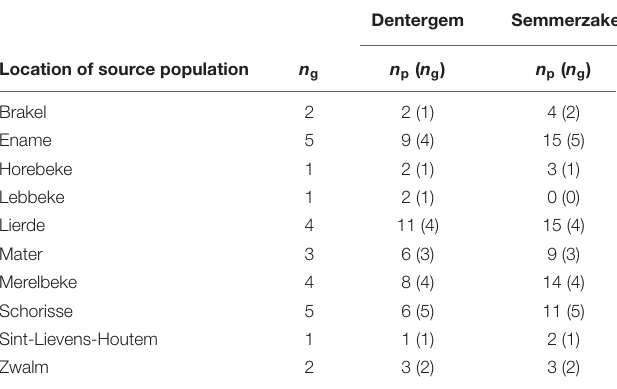
TABLE 1 | Source material for the clone